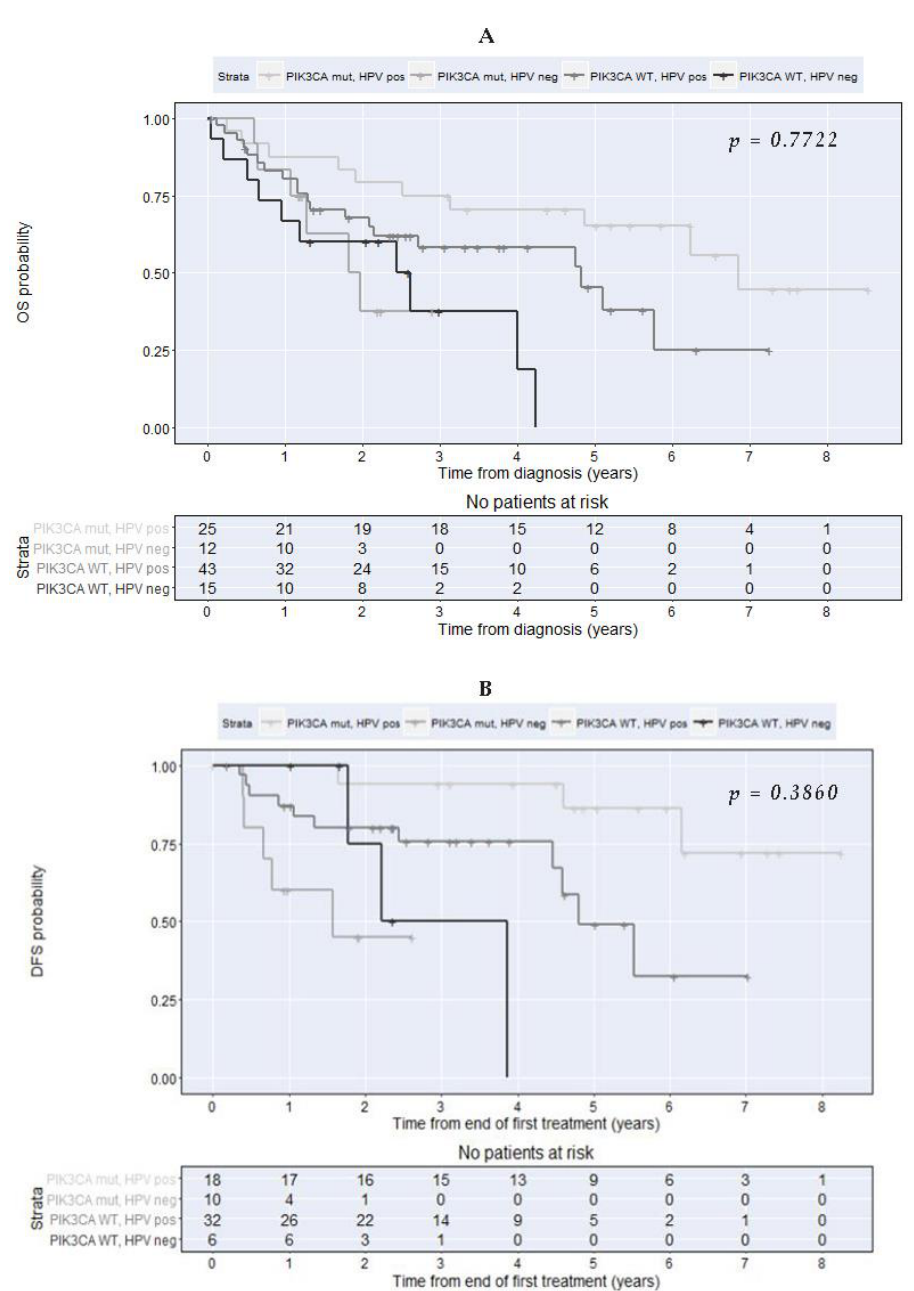
Figure 3. Kaplan – Meier plots for overall survival ( A ) and disease-free survival ( B ) by PIK3CA mutation and HPV status at diagnosis ( p = 0.3860).